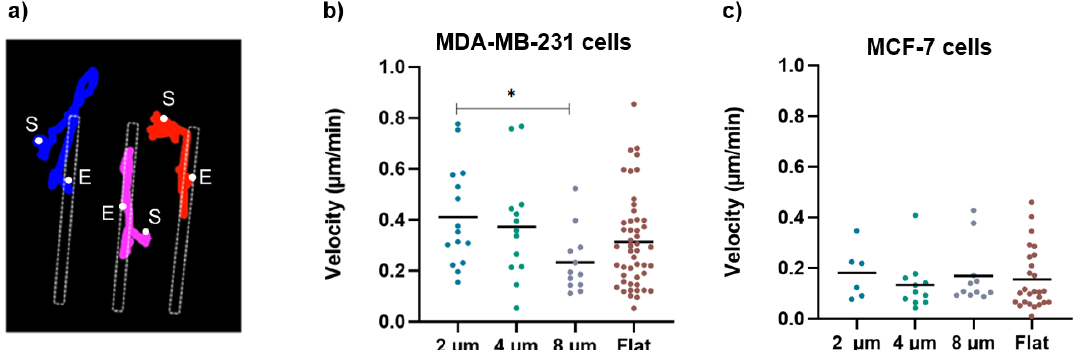
Figure 8. ( a ) An example of cell-tracking analysis for cells grown on 4 um wide micro-gaps to calculate the velocity of migrating cells. The colored lines indicate the trajectories obtained for different cells during migration analysis (S = start point; E = end point). ( b ) Velocity values for MDA-MB-231 cells on 2 µm (n = 15), 4 µm (n = 13), and 8 µm (n = 12) wide micro-gaps and on flat membranes (n = 48). ( c ) Velocity values for MCF-7 cells on 2 µm (n = 6), 4 µm (n = 11), and 8 µm (n = 11) wide micro-gaps and on flat membranes (n = 26). The black line is the mean value for each data set.